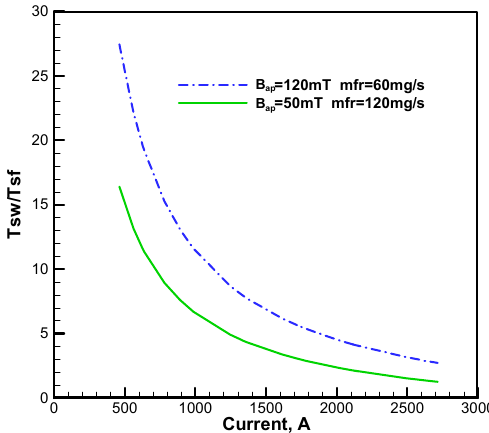
Figure 5. Variations of swirls to self-field thrust ratio with currents.